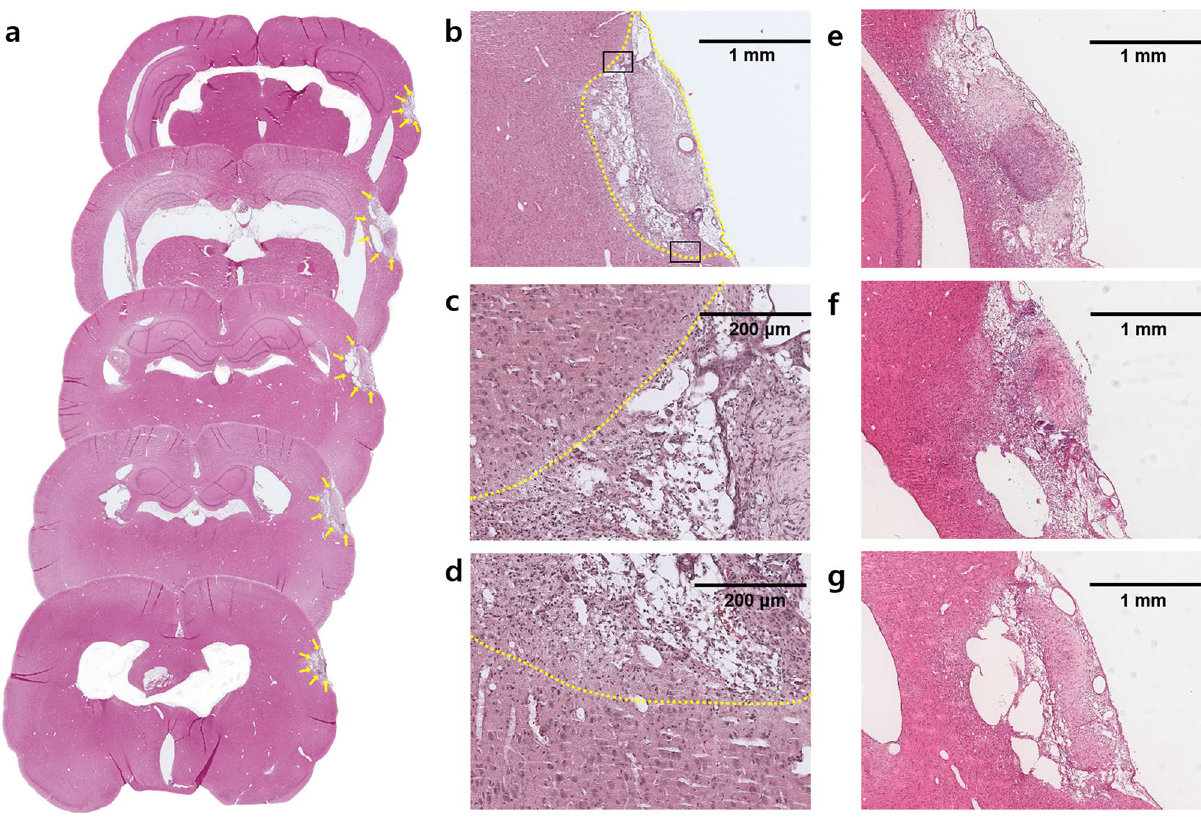
Figure 4. Histologic findings of stroke models on haematoxylin and eosin staining. ( a ) An overview of multiple coronal sections of the rat brain showing the stroke lesion from rostral (top) to caudal (bottom). The arrows indicate the boundary of the ischemic lesion. ( b ) An example of the coronal section indicating the outline of the infarcted area shown by the dashed line. ( c , d ) High-power view of the boxed regions in ( b ). The demarcated zone of pale-staining cortex indicates the infarcted area, surrounded by mononuclear inflammatory cell infiltration. ( e ) A coronal section of mild stroke, (f) moderate stroke, and ( g ) severe stroke. As the stroke became severe, destructive changes such as cystic cavitation also